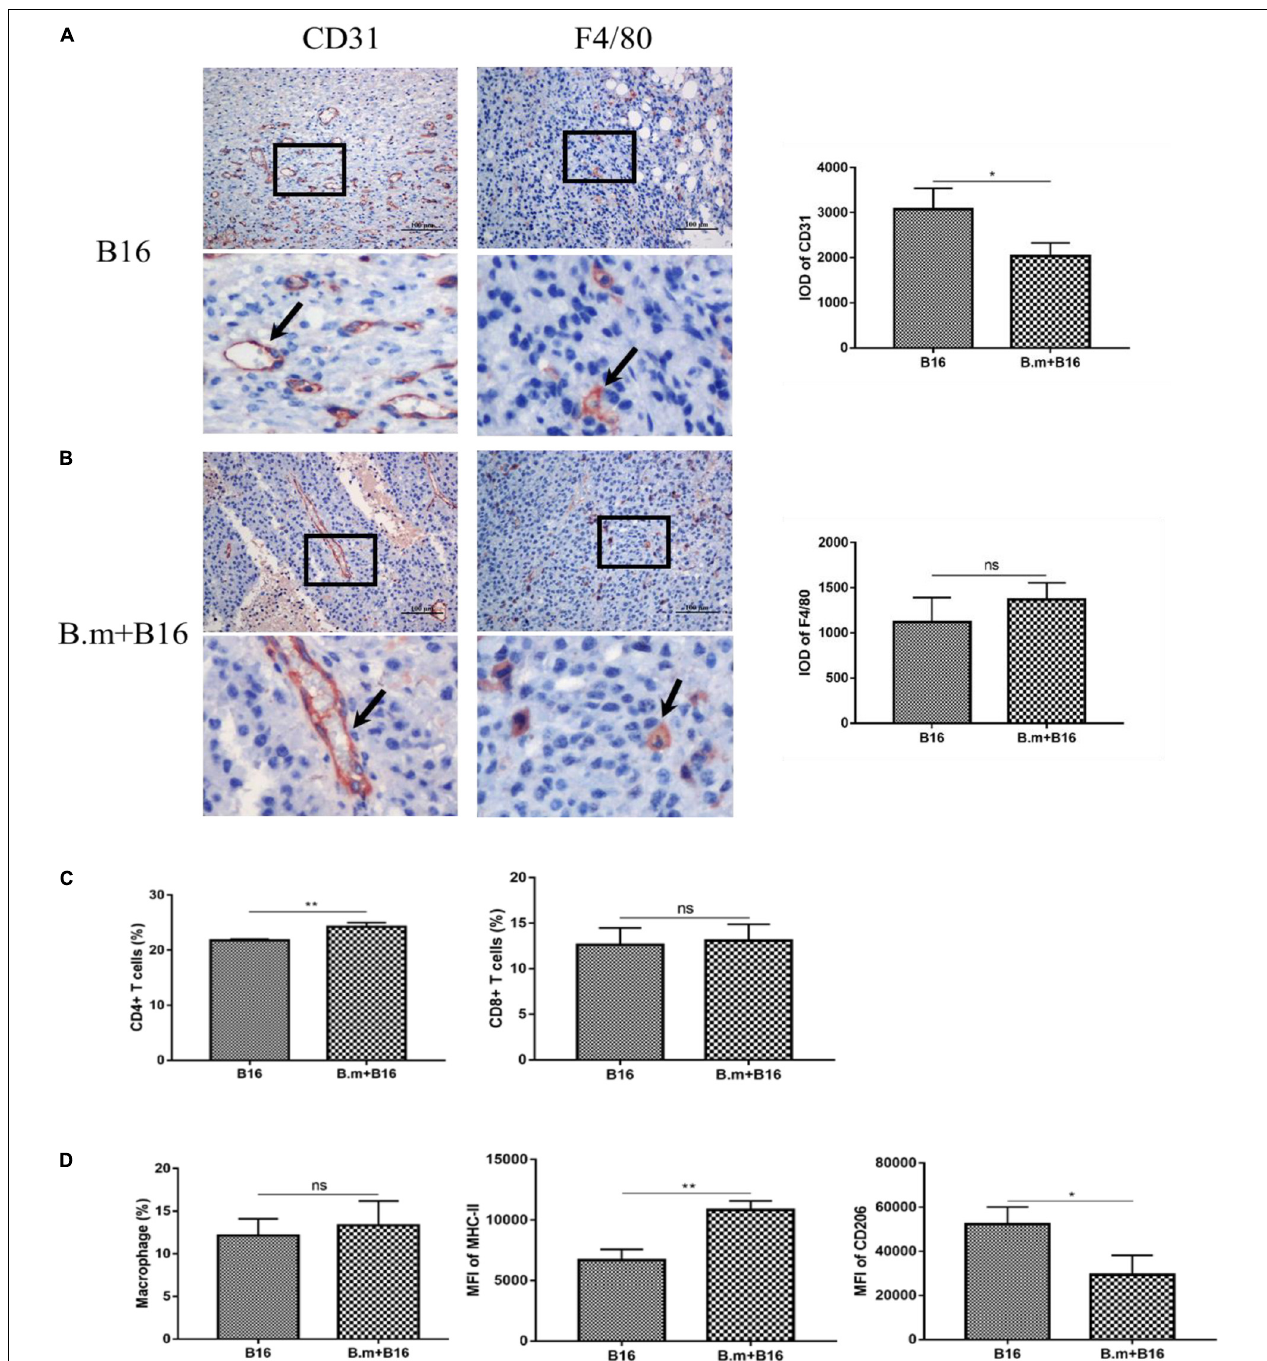
FIGURE 4 | Effects of B. microti infection on tumor angiogenesis and tumor immune microenvironment. (A,B) Immunohistochemical analysis of the expression of CD31 and F4/80 in mouse tumor tissues, with positive staining indicated by arrows. IOD of positive staining was statistically analyzed using IPP software (right panel). (C) Proportion of CD4+ and CD8+ T cells in tumors. (D) Proportion of macrophages in tumors (left panel), and the median fluorescence intensity (MFI) of MHC-II and CD206 in macrophages (middle and right panels). Error bars are SD; * p ≤ 0.0332, ** p ≤ 0.0021, ns: no